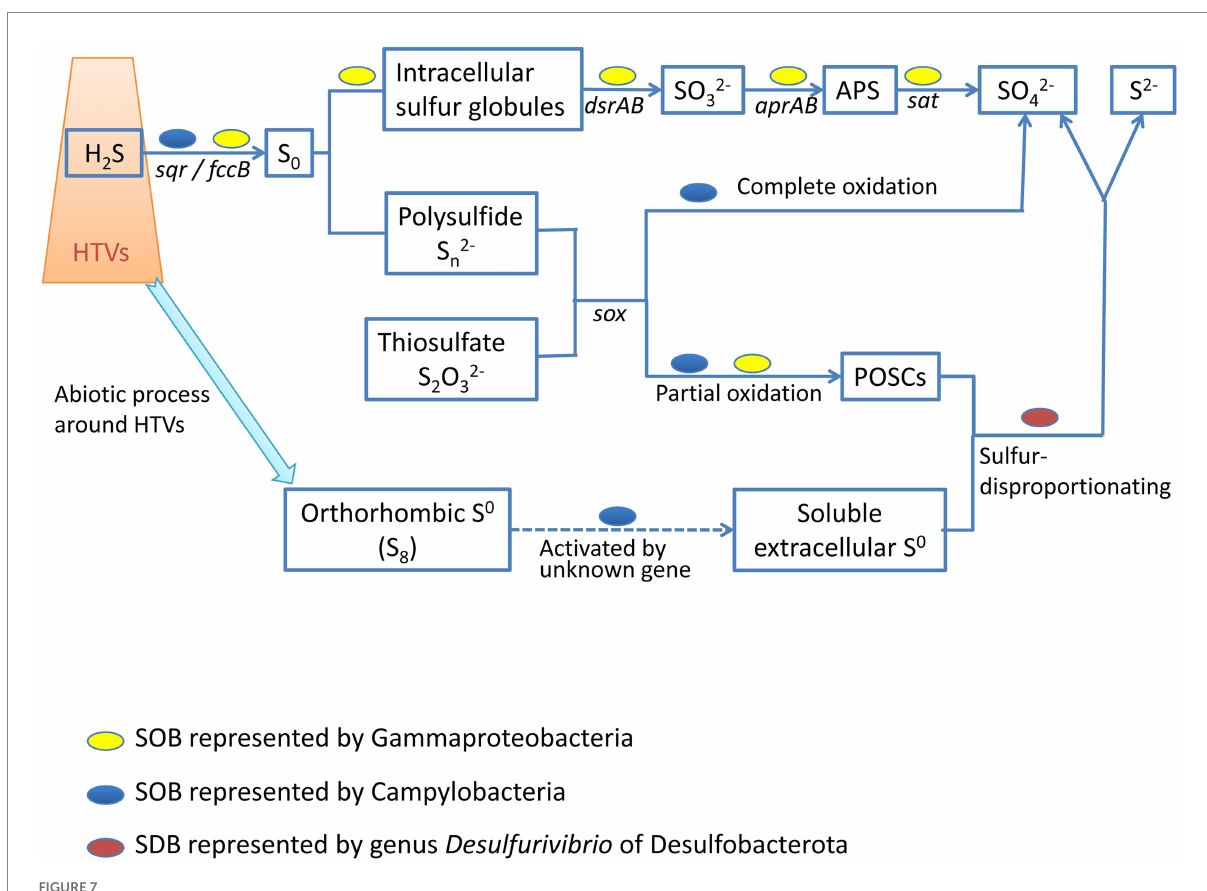
FIGURE 7 Schematic diagram showing relationship of the abundant MAGs involving in the sulfur cycle. Although both Gammaproteobacterial and Campylobacterial SOB can oxidize various sulfur form (H 2 S, Sn 2- , S2O3 2- , etc.), their mechanism and processes were different. Gammproteobacteria (colored with yellow) can form intracellular sulfur globules and use reverse dissimilatory sulfite reductase (encoded by dsrAB gene) to form oxidative sulfate, while Campylobacteria (colored with blue) use the Sox multi-enzymes to form sulfate, or partially oxidized sulfur compounds (POSCs) when the availability of electron acceptor such as oxygen and nitrate was limited. The formed POSCs or soluble extracellular S 0 activated by some kind of Campylobacteria can offer growth for SDB (colored with red). SOB: sulfur-oxidizing bacteria; SDB: sulfur disproportionation